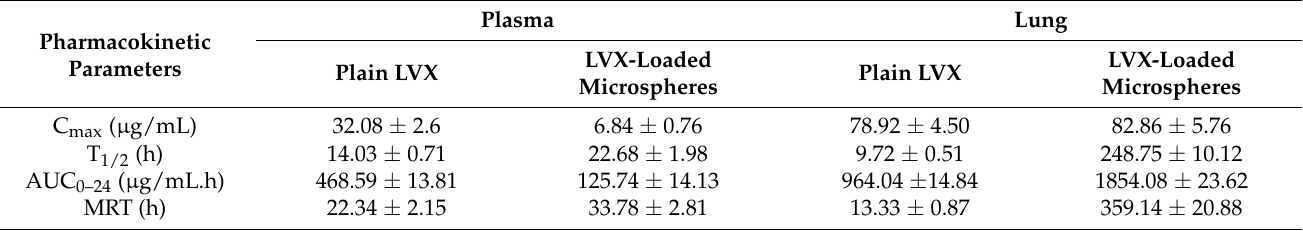
Table 5. Non-compartmental pharmacokinetic parameters of plain LVX and LVX-loaded microspheres following pulmonary